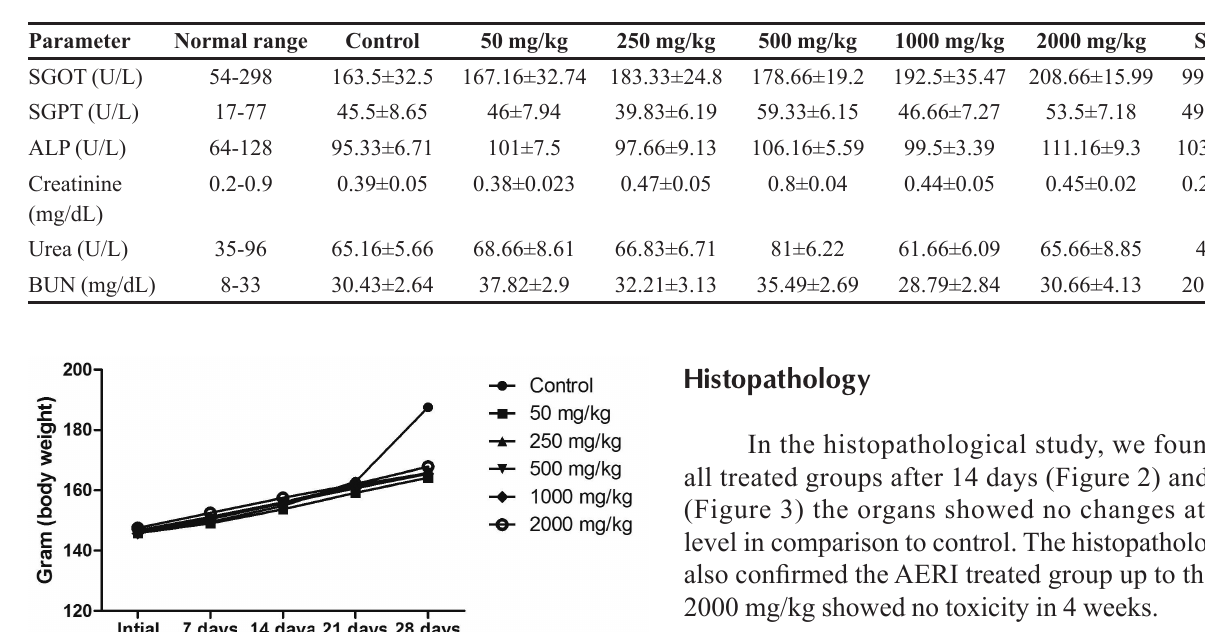
TABLE VI - Biochemical estimation from blood serum of rats after 28th day’s treatment at different dose level in sub- acute toxicity study